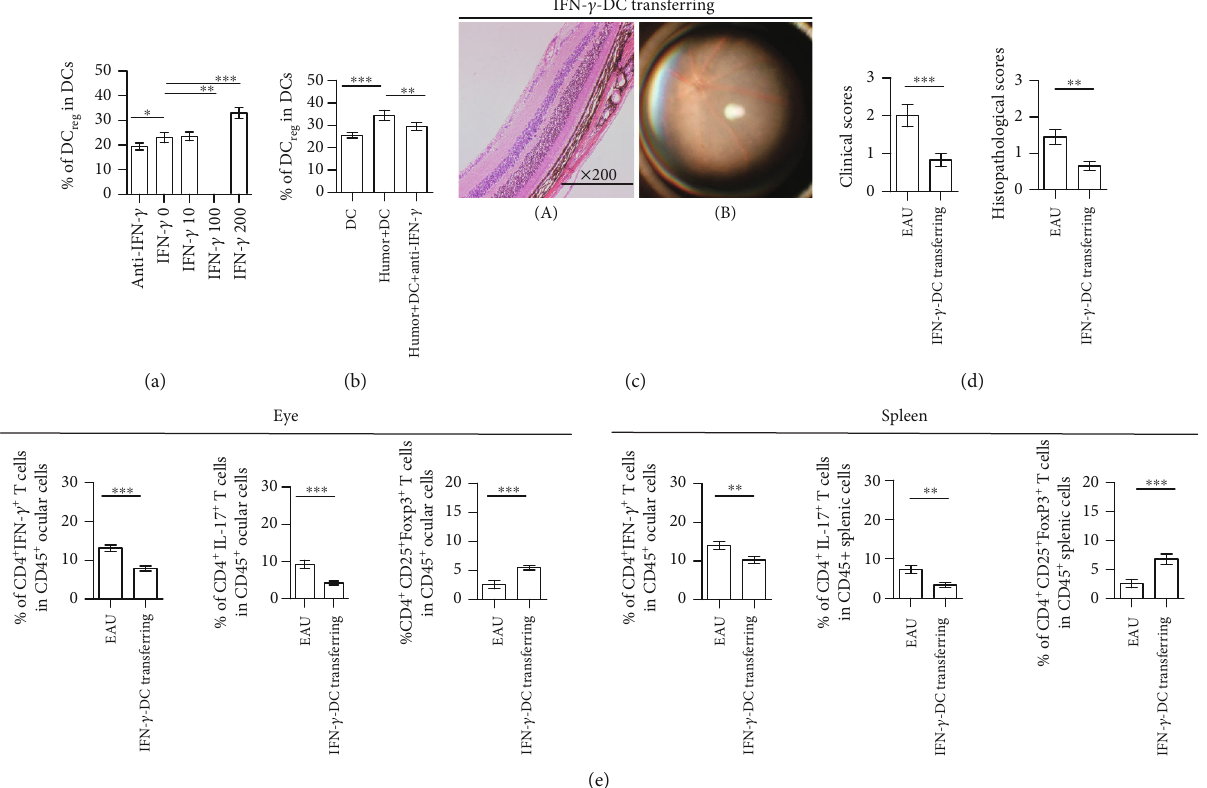
Figure 5: The e ff ect of IFN- γ on DCs in vitro and IFN- γ -treated DCs on EAU. (a) With di ff erent concentrations of IFN- γ treatment or anti- IFN- γ -neutralizing antibodies (2 μ g/ml), the percentage of DC in DCs isolated from the eyes of normal mice is shown. Mouse IFN- γ was reg used as 0U/ml (IFN- γ 0), 10U/ml (IFN- γ 10), 100U/ml (IFN- γ 100), and 200 U/ml (IFN- γ 200) separately. The experiment was replicated three times, data were presented as mean ± standard error of the mean (SEM), ANOVA test, and ∗ P < 0 : 05 , ∗∗ P < 0 : 01 , and ∗∗∗ P < 0 : 001 . (b) The percentage of DC in DCs, which with aqueous humor or aqueous humor added with anti-IFN- γ -neutralizing antibody (2 μ g/ml) reg compared with those without treatment. The experiment was replicated three times, data were presented as mean ± standard errorof the mean (SEM), ANOVA test, and ∗∗ P < 0 : 01 . (c) Histopathological change of eyes (A) and clinical symptom (B) were assessed in IFN- γ - treated DC-transferred mice by H&E staining and funduscopy on the 16th d of postimmunization. H&E staining of the retina at 200x magni fi cation. Scale bar = 100 μ m. (d) The histopathological and clinical scores were evaluated in IFN- γ -treated DC-transferred mice, compared with those of nontreated EAU mice. (e) The percentage of CD4 + IFN- γ + T cells, CD4 + CD25 + Foxp3 + T cells, or CD4 + IL-17 + T cells in CD45 + lymphocytes of eyes and spleen of IFN- γ -treated DC-transferred mice compared with that of nontreated EAU mice. (d, e) n = 10 /group, and experiments were replicated three times, data were presented as mean ± standard error of the mean (SEM), two-tailed Student ’ s t -test, and ∗ P < 0 : 05 , ∗∗ P < 0 : 01 , and ∗∗∗ P < 0 : 001